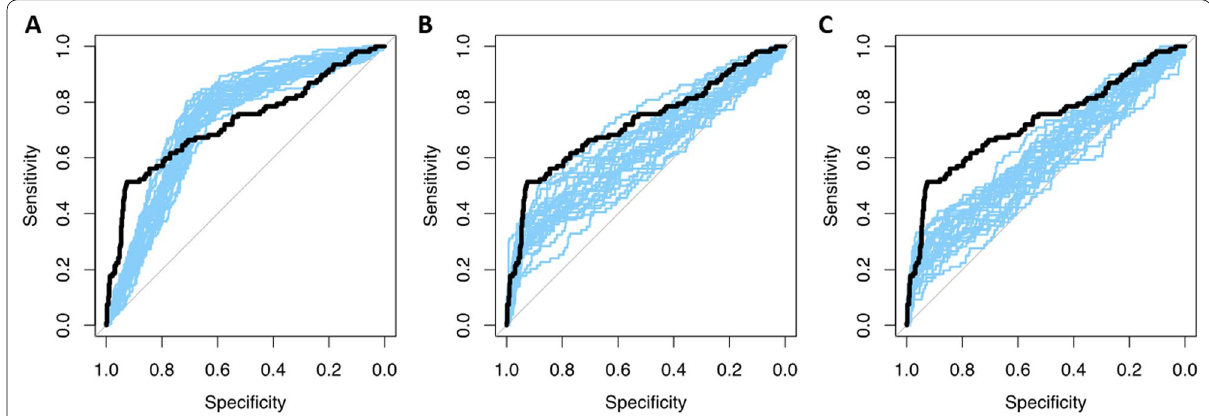
Fig. 3 AUCs of 25 repeats of external simulated datasets varying the positivity rate in blue with the simulated true expected AUC in black A positivity rate of 0.10, B positivity rate of 0.66, C positivity rate of